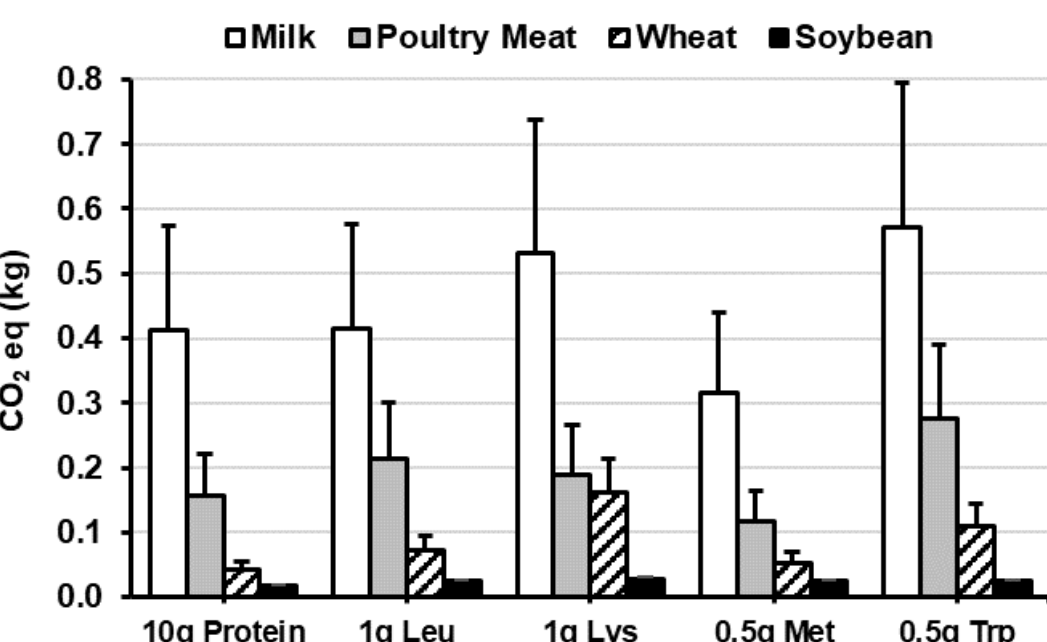
Figure 3. Carbon dioxide (CO 2 ) emission equivalents per g dose of digestible protein and the essential amino acids (Leu, Lys, Met, Trp) for whole milk, cooked poultry meat, wheat and soybean flour. Data are mean + standard deviation (SD). CO 2 data [57]; nutrient data [24,27].